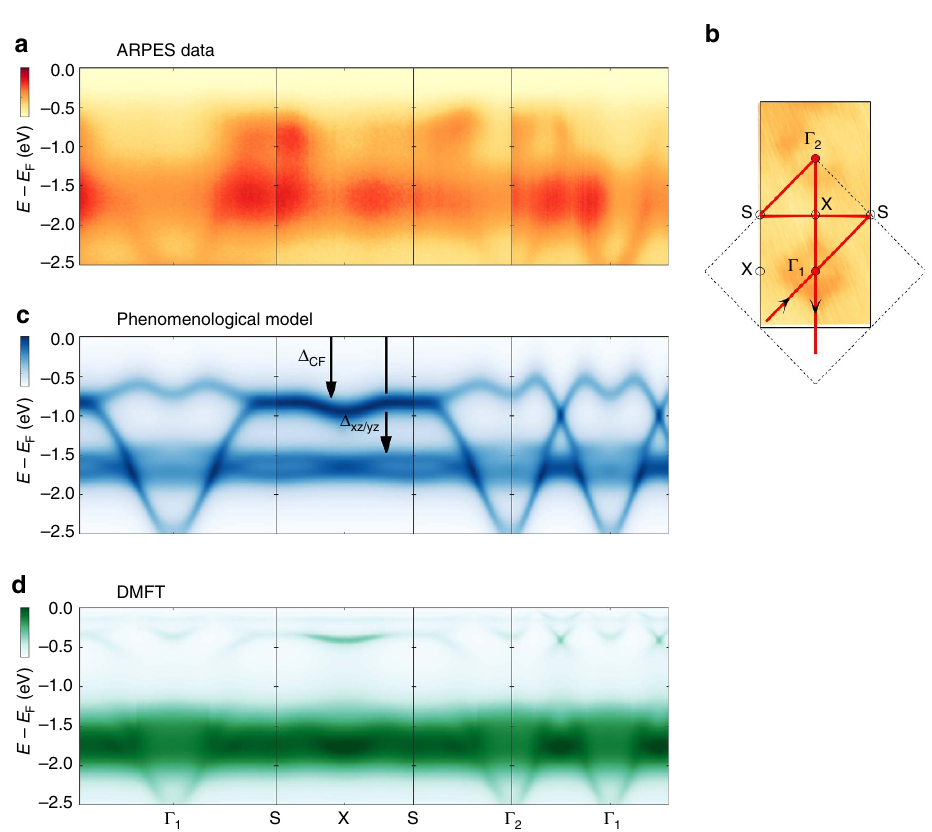
Figure 3 | Band structure along high-symmetry directions. ( a ) ARPES spectra recorded along high-symmetry directions with 65eV circularly polarized light. ( b ) Constant energy map at binding energy E (cid:2) E F ¼ (cid:2) 2.7eV. ( c ) DFT-derived spectra for Ca 2 RuO 4 , upon inclusion of a Mott gap D xz / yz ¼ 1.55eV acting on d xz , d yz bands and an enhanced crystal field D CF ¼ 0.6eV, shifting spectral weight of the d xy bands (for details, see Methods section) and plotted with spectral weight representation. ( d ) DMFTcalculation of the spectral function, with Coulomb interaction U ¼ 2.3eV and a Hund’s coupling J ¼ 0.4eV. Dark colours correspond to high